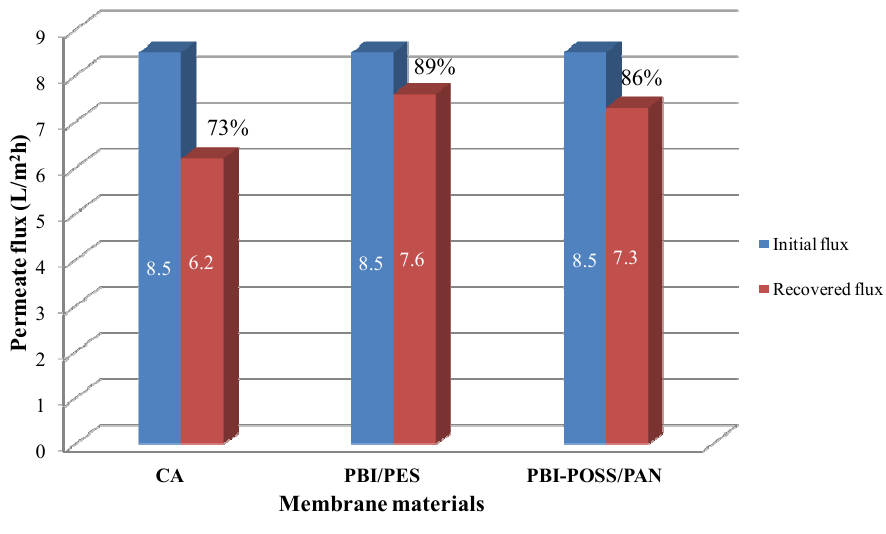
Figure 12. Comparison of cleaning efficiency on CA, PBI/PES and annealed PBI-POSS/PAN membranes. The initial flux was 8.5 L/m 2 h. Blue areas are the initial permeate fluxes of fresh membranes in scaling experiments under the FO mode. Red areas are the recovered